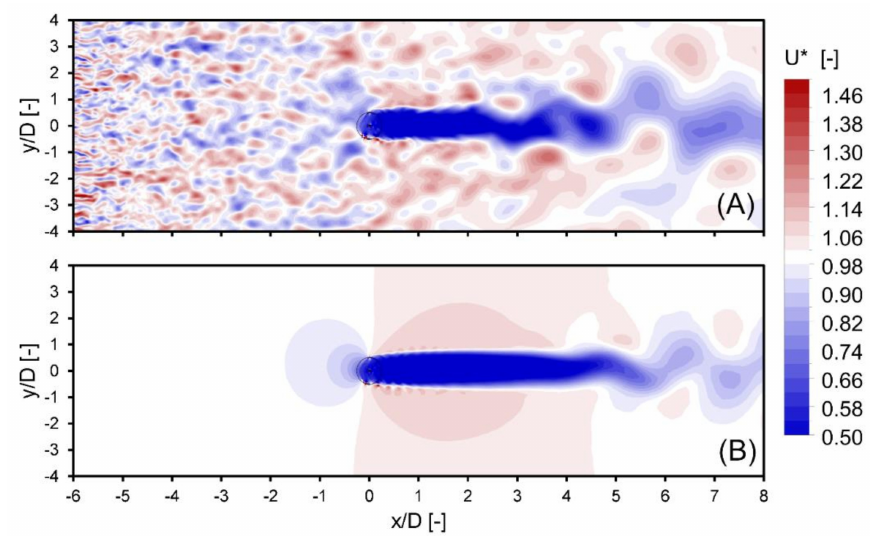
Figure 1. Computed contours for the dimensionless streamwise velocity: ( A ) turbine simulation with turbulence, and ( B ) turbine simulation without turbulence.